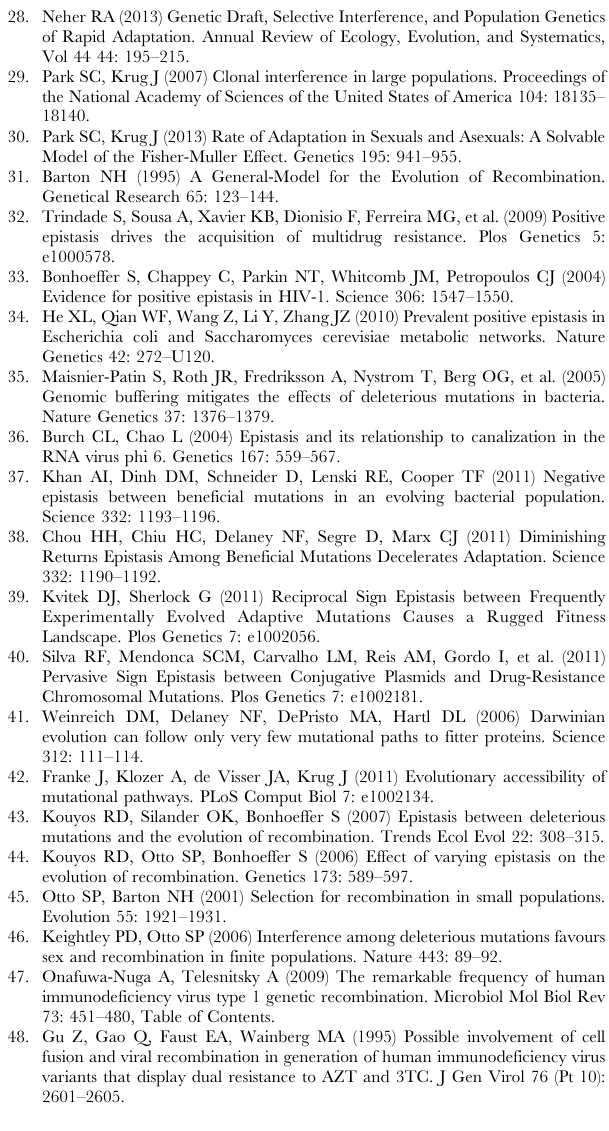
simulations at a different mutation rate. The error bars show the 95% confidence intervals. The dashed lines show the initial frequency of the recombining population (0.01). The population size was always set to N ~ 10 5 . (TIFF) Text S1 File contains information about the supplementary